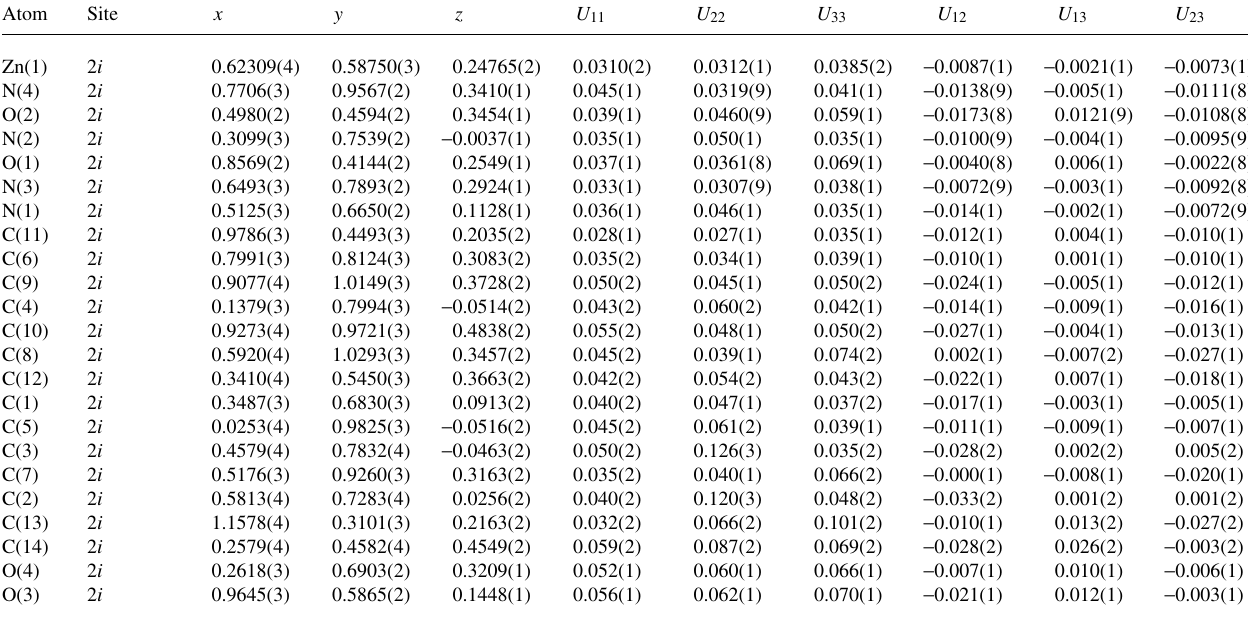
Table 3. Atomic coordinates and displacement parameters (in Å 2 )